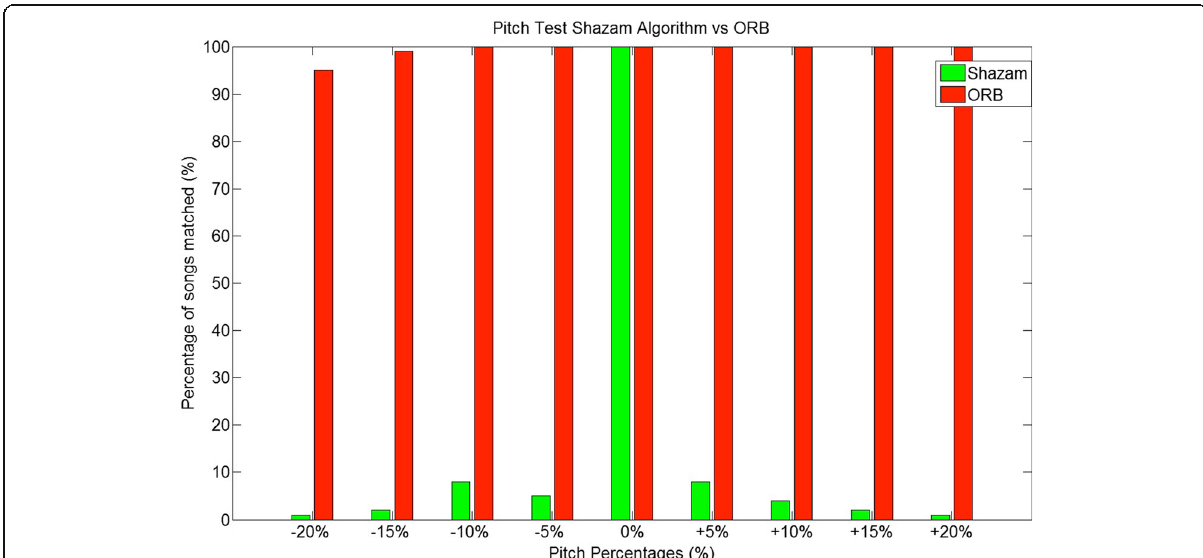
Fig. 4 Pitch test for robustness (Shazam vs ORB). This figure involves the pitch test where audio samples were queried to be correctly identified when pitch distortions are applied. Pitch distortion would cause the frequencies in the audio sample to shift vertically. The time synchronization would remain the same, and there are no temporal changes involved. The test was done similarly to the speed where a random 20-s clip was taken from each song in the database, and the pitch distortion was applied. The typical range was tested ( − 10 to +10%), but the limits of the prototypes were tested ( − 20 to +20%). It was seen that the ORB prototype produced better results compared to the Shazam